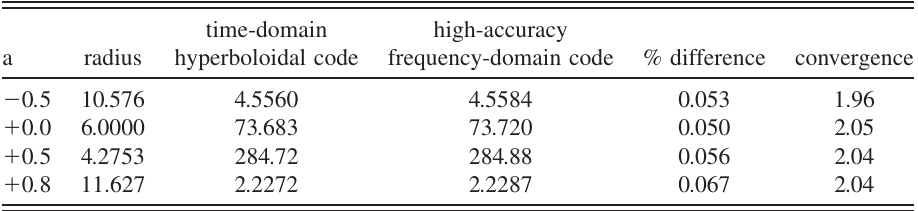
TABLE I. This table depicts the numerical values of energy fluxes for the j m j ¼ 2 mode from various circular-equatorial orbits, computed by the time-domain hyperboloidal code) and a high- accuracy frequency-domain code. The flux values are scaled up with the square of the inverse mass-ratio ( (cid:8) (cid:1) 2 ) and by a factor of 10 5 . The convergence rate is also presented.